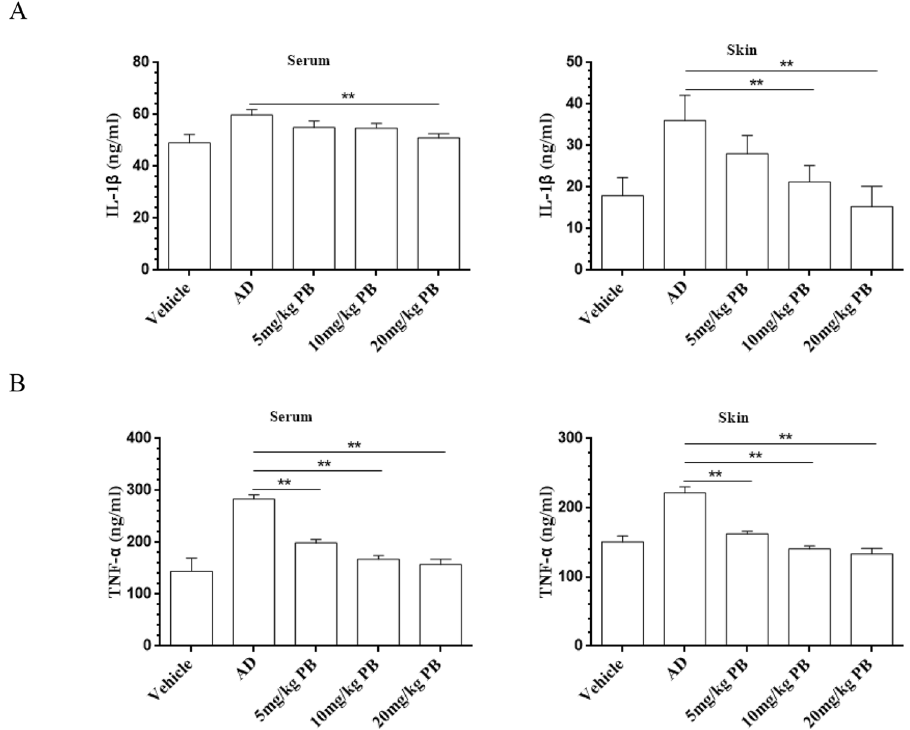
Figure 3. Suppression of PB on IL-1 β and TNF- α in NC/Nga mice. The concentrations of IL-1 β and TNF- α in serum and lesional skin tissues were detected by ELISA. ( A ) IL-1 β . ( B ) TNF- α . Data are representative of two independent experiments and presented as mean ± SD of n = 8 mice per group. ** P < 0.01. Vehicle, intact mice with saline treatment; AD, DNFB-sensitized and challenged mice; PB, pseudolaric acid